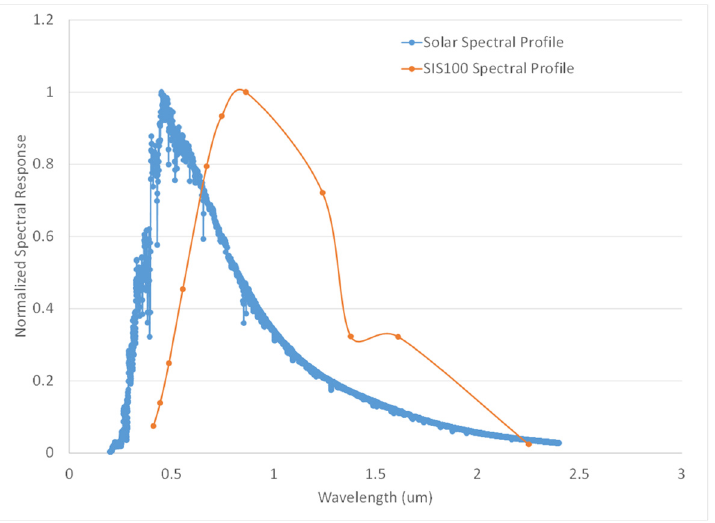
Figure 5. A comparison of the on-orbit solar spectral irradiance profile and the SIS100 radiance profile. The OOB RSR contributions are not weighted the same in on-orbit and prelaunch applications.